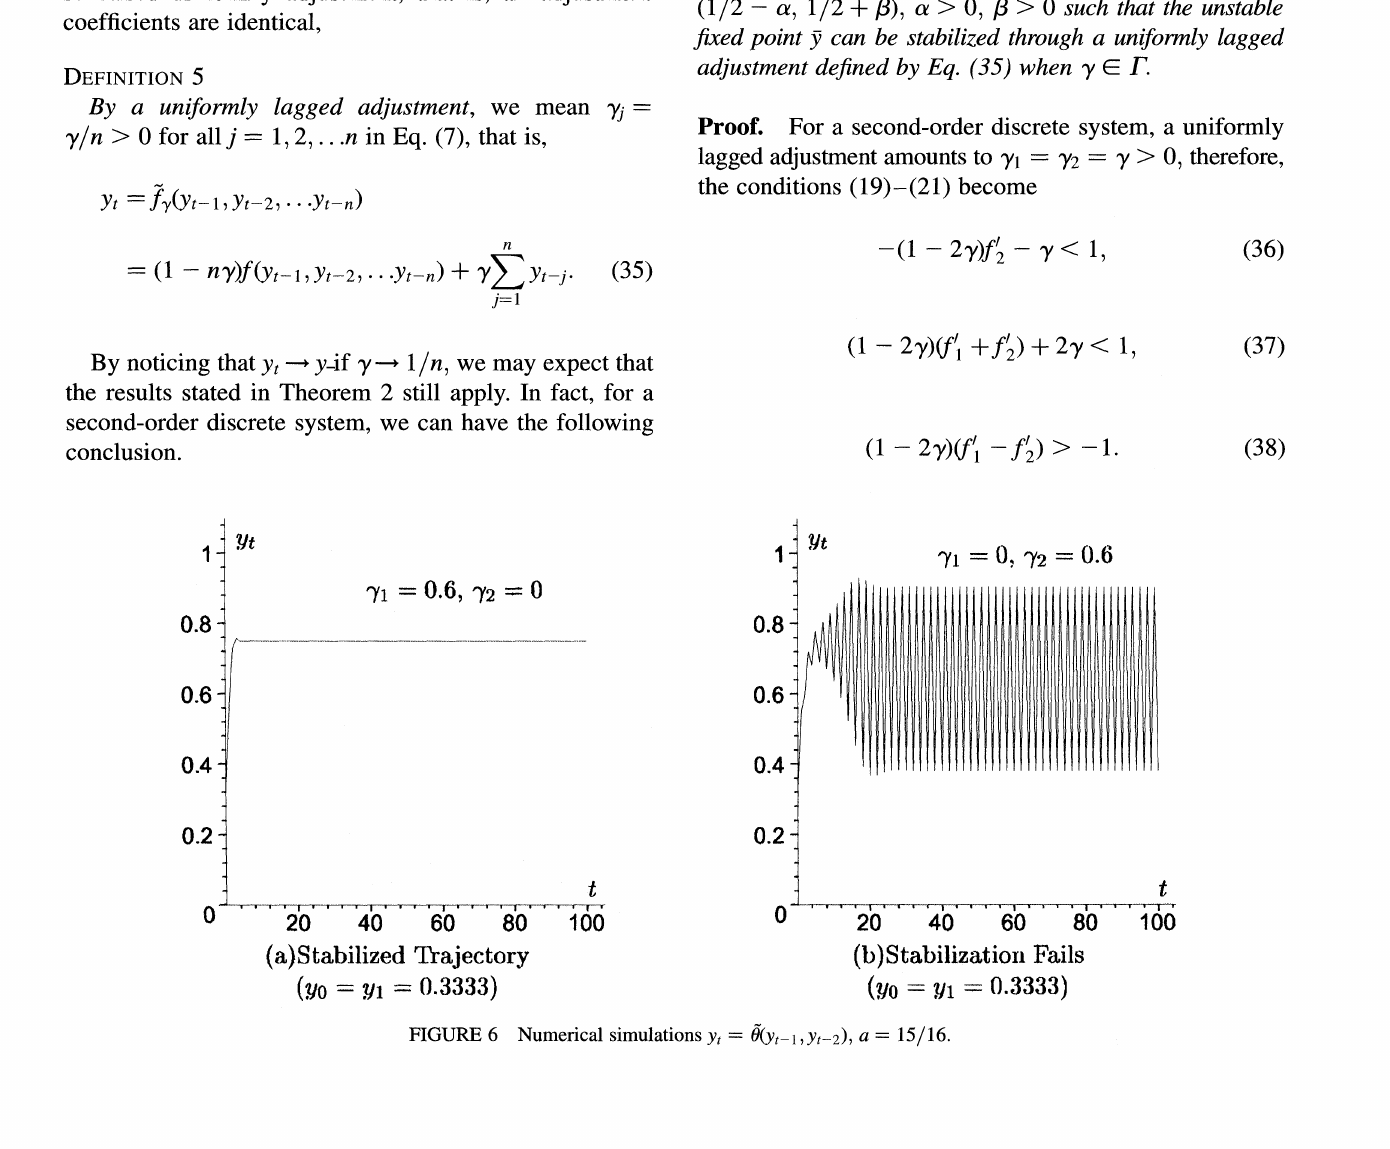
FIGURE 5 Numerical simulations Yt O(yt-l,yt-2), a 15/16.